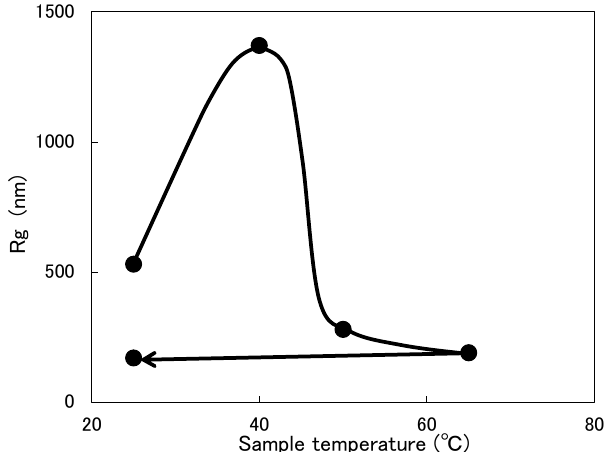
Figure 9. Relationship between sample temperature and M W (surfactant: E-212 with DBTL).